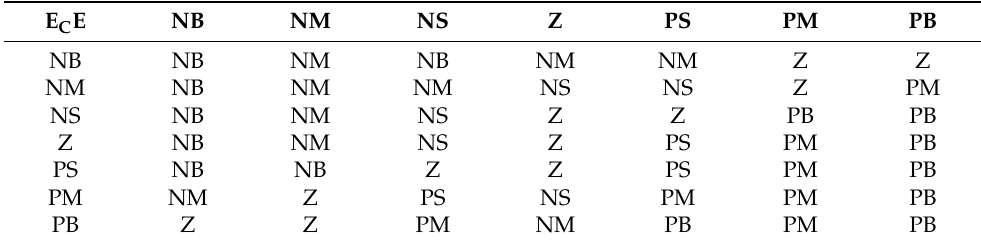
Table 3. Fuzzy control rule for ∆ K i .